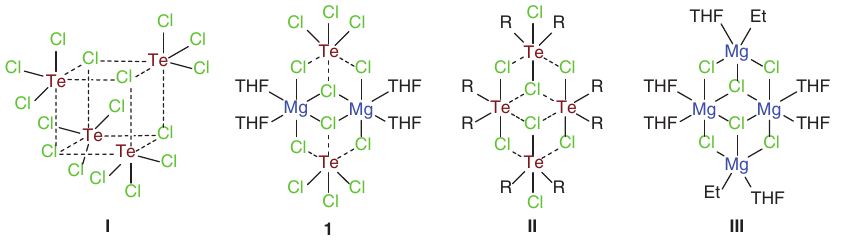
Table 1 Crystal data and structure refinement of Te